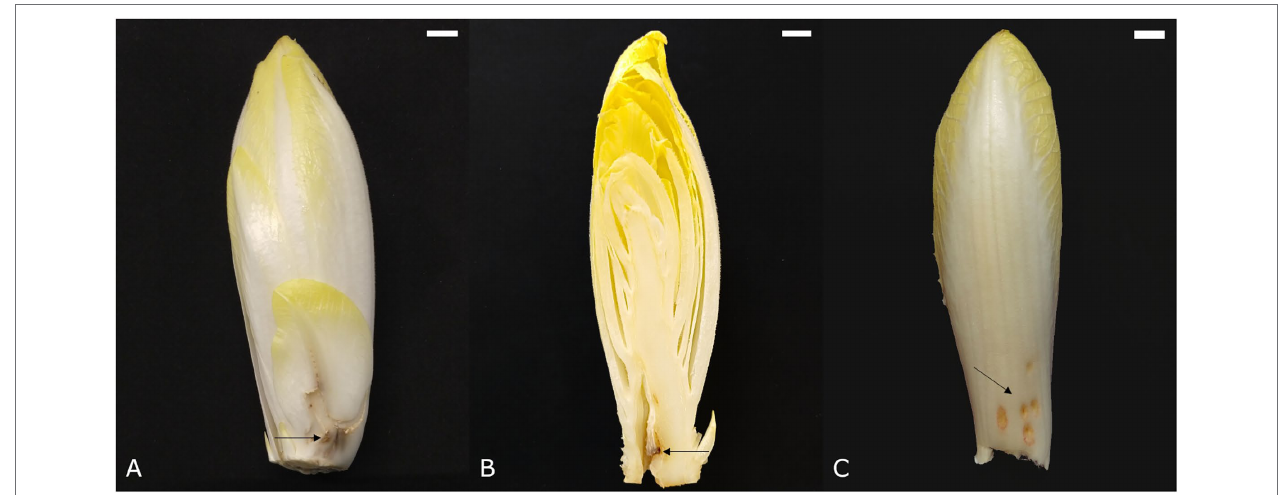
FIGURE 4 | Symptoms of point noir on (A) an outer leaf and (B) the pith. (C) Symptoms of chilling injury. Scale bars represent 1